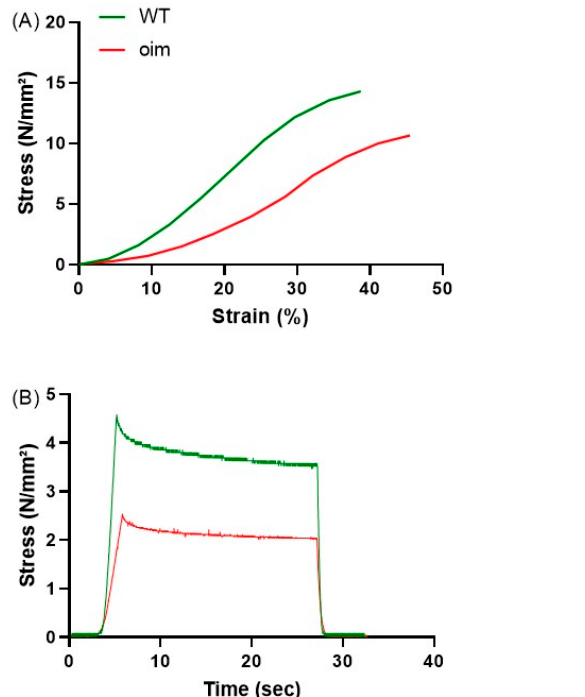
Figure 2. Biomechanical parameters of flexor digitorum longus (FDL) tendons in 5-week-old WT and oim mice. ( A ) Stress–strain curve of one WT mouse (green line) and one oim (red line). ( B ) Evolution of stress through time during a cycle of deformation in the same tendons as in A. ( C – F ) Ultimate stress (N/mm 2 ), ultimate strain (%), toughness (N/mm 2 ) and elastic modulus (N/mm 2 ) of FDL tendons. n = 7 for oim and 9 for WT mice. * p < 0.05, ** p < 0.01.